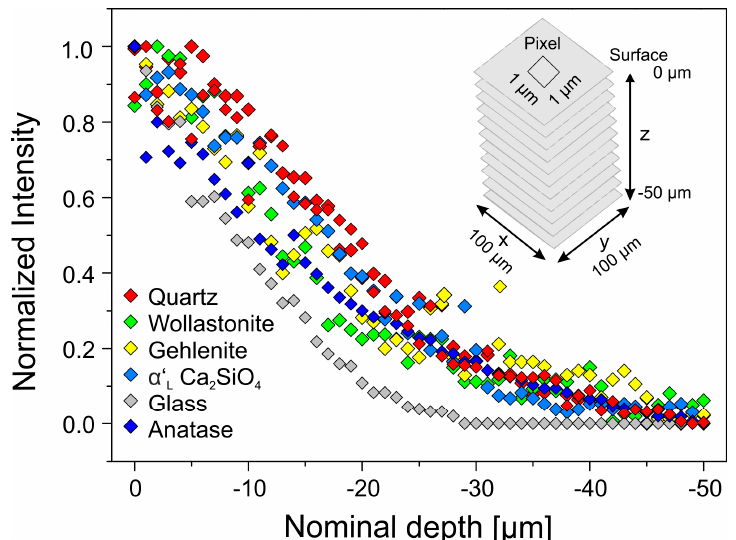
Figure 9. RT hyperspectral Raman images of a fired CaO-SiO 2 -Al 2 O 3 ceramic recorded with a different confocal pinhole. Note that images acquired with a pinhole smaller than 300 µ m show the worst quality due to significantly lower band intensities, whereas with larger confocal pinholes morphological details get lost. For instance, the small rutile grains (purple) that are clearly distinguishable in those images recorded with a pinhole smaller than 400 µ m are increasingly “grown” together and appear to be one single grain in the images recorded with a confocal pinhole larger than about 800 µ m.